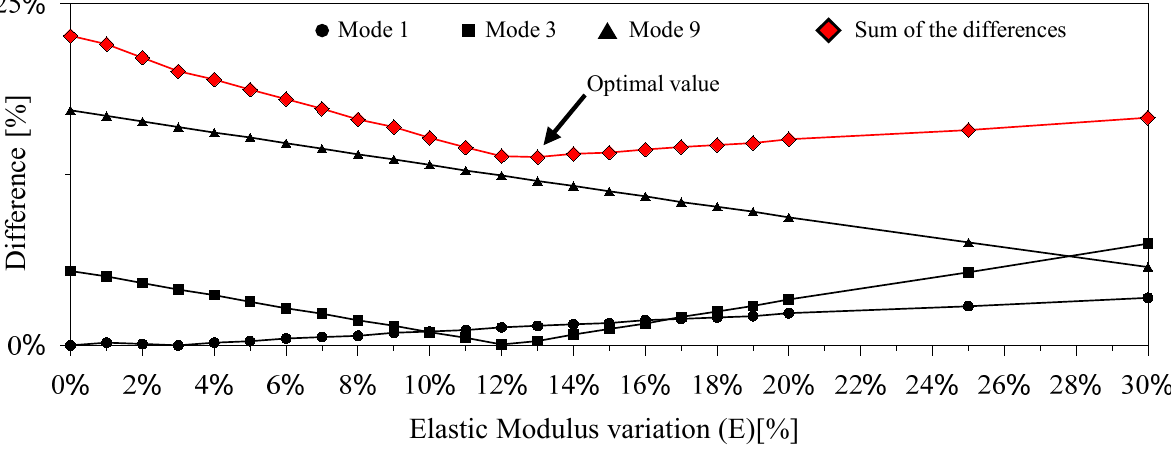
Figure 16. Parametric analysis increasing the Elastic Modulus of the numerical frequencies related to the modes 1, 3, and 9. Results shown in the terms of percentage difference.